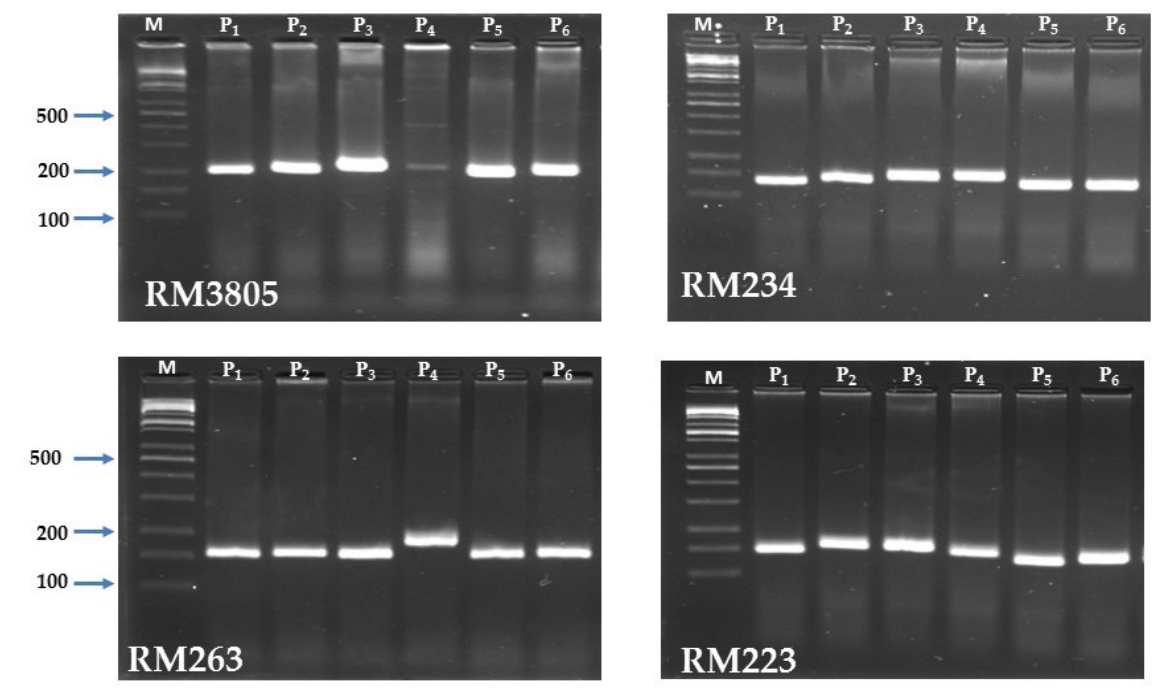
Figure 5. PCR amplified fragments for the SSR markers RM263, RM223, RM234, and RM3805 with the six parental rice genotypes. M is a 100 bp DNA ladder.